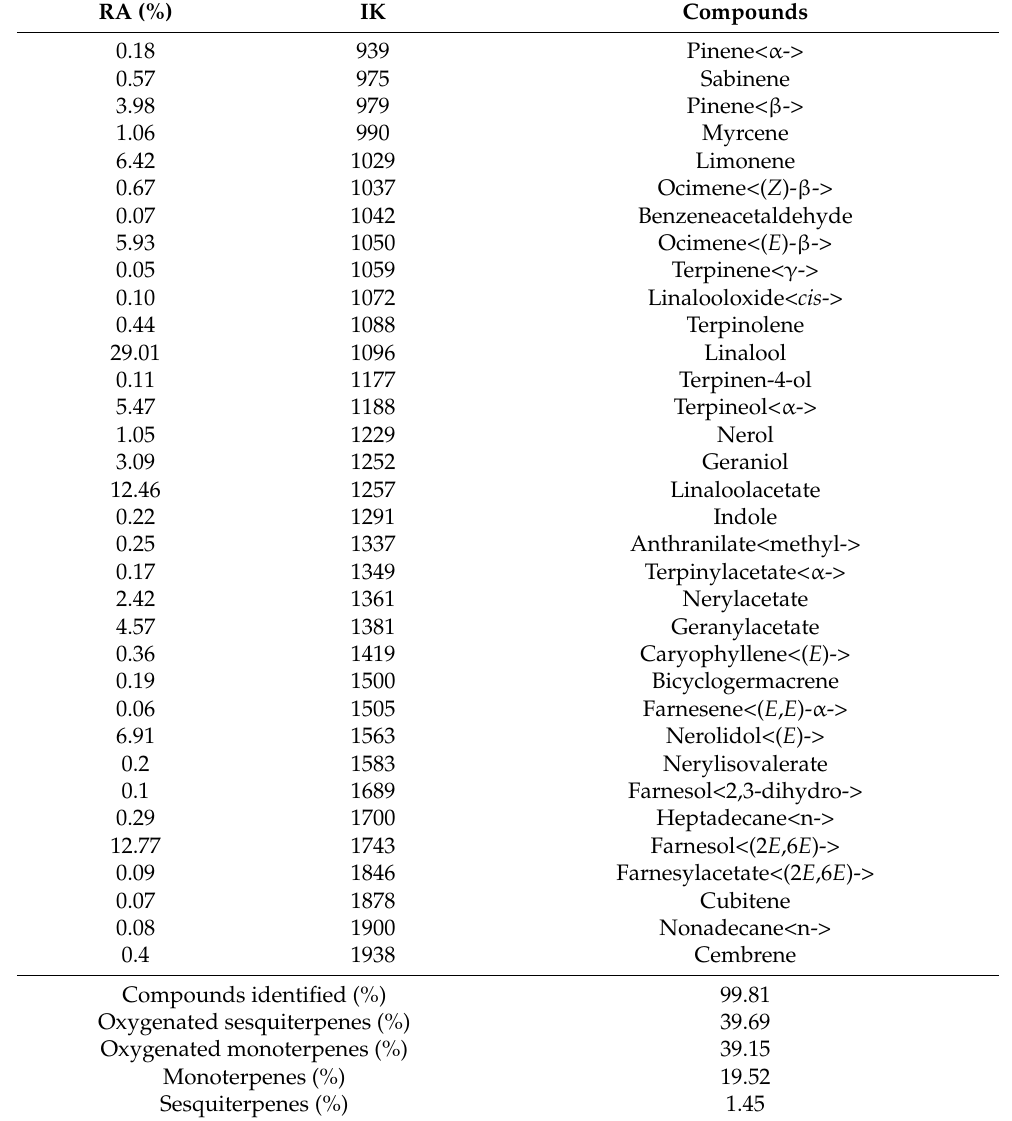
Table 7. The chemical composition of EO of Citrus aurantium